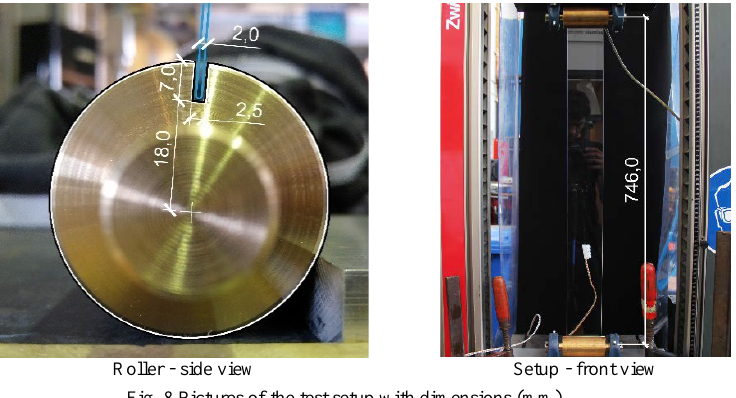
Fig. 8 Pictures of the test setup with dimensions